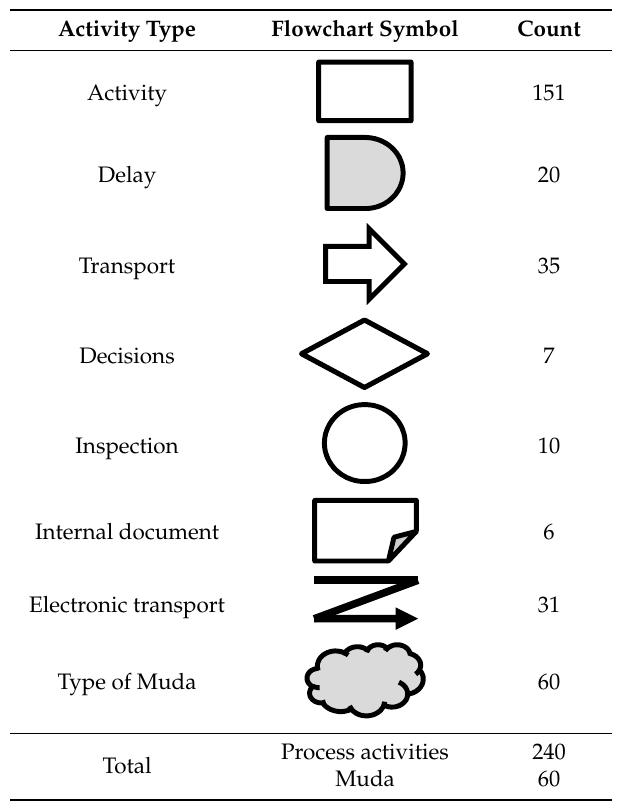
Table 3. Analysis of hip fracture process activities.